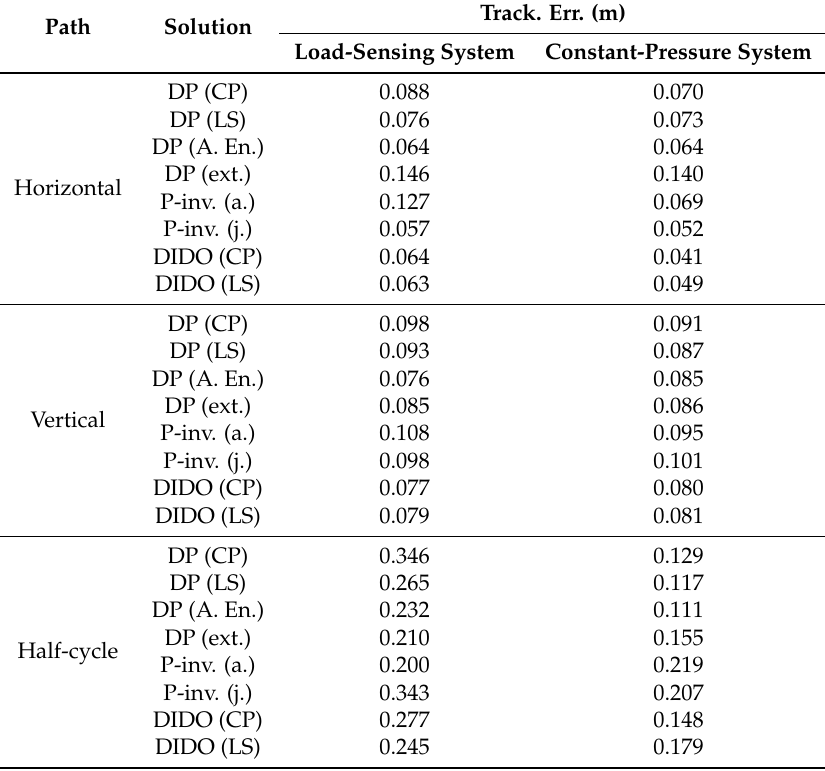
Table 4. Maximum end-effector path tracking errors in each redundancy resolution computed according to ISO 9283 standard